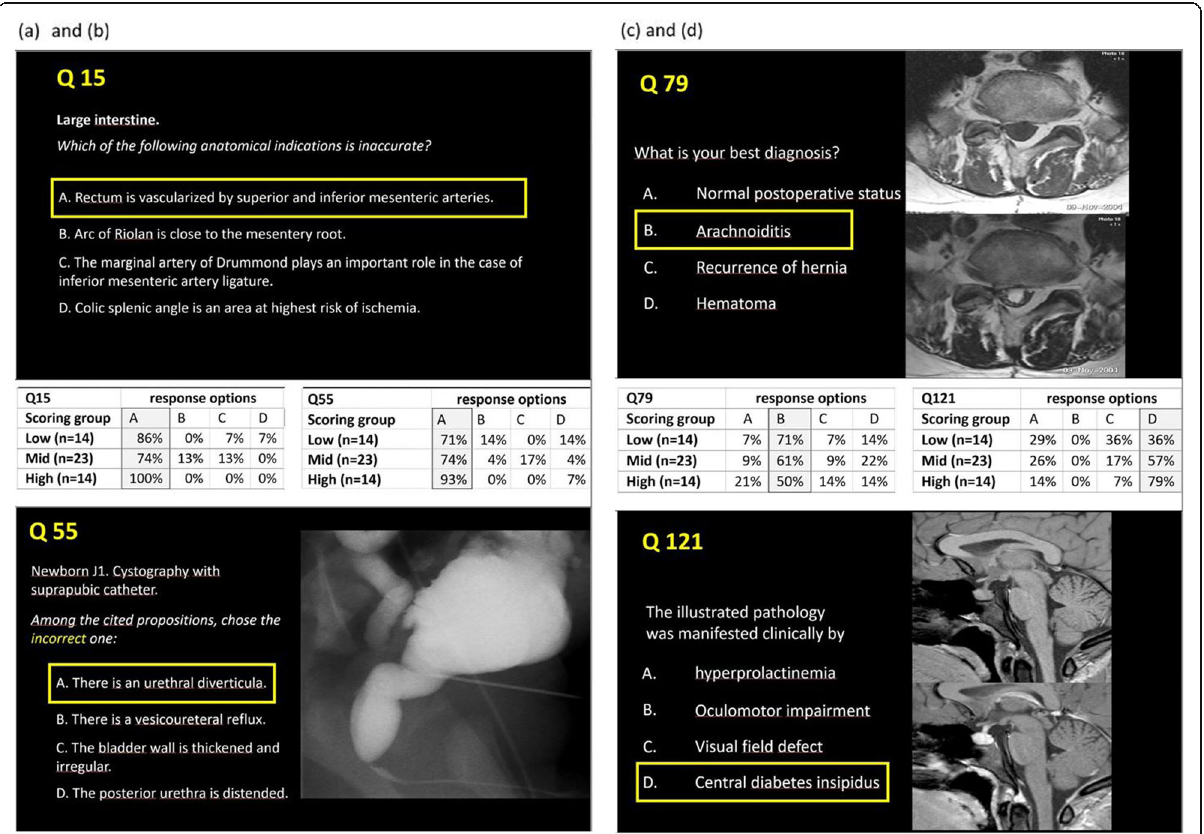
Fig. 3. Examples of MCQ resident and of MCQ teacher . Correct answer options are highlighted. Percentage indicates the frequency each answer option has been selected by the residents who are classified according to their global performance in this exam. a Q15 (MCQ resident ) was easy (difficulty index = 0.84) and not discriminant (discriminant index = 0.05); it required only recalling skill. b Q55 (MCQ resident ) had an ideal difficulty index (0.78) and was discriminant (discriminant index = 0,36); correct answer required application/analysis skills. c Q79 ( MCQ teacher ) had an ideal difficulty index (0.61) but was not discriminant ( − 0,15); correct answer required comprehension/application skills. d Q121 ( MCQ teacher ) had an